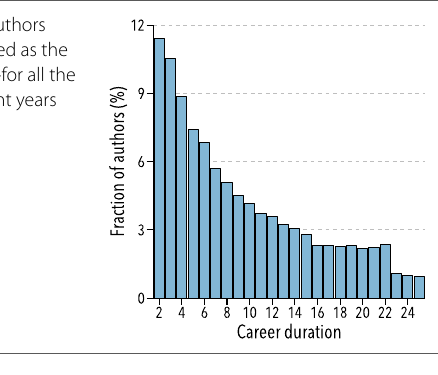
Figure 1 Career duration distribution of the 103,246 authors considered. Distribution of the career duration-measured as the number of years between the first and the last paper—for all the 103,246 authors with at least two papers in two different years present in our dataset